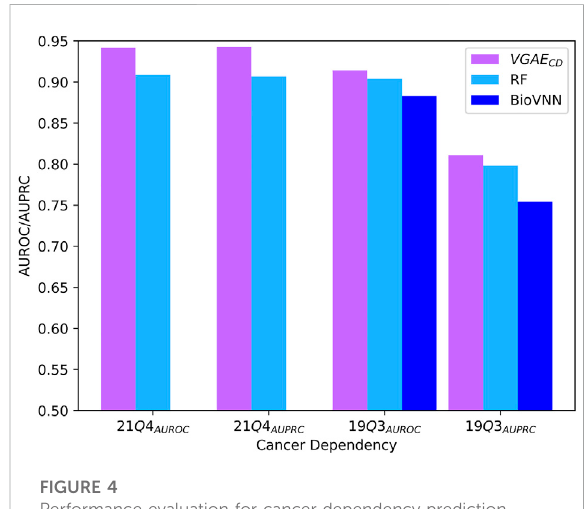
FIGURE 4 Performance evaluation for cancer dependency prediction on the two evaluated datasets. The presented BioVNN results are taken from (Lin and Lichtarge, 2021).